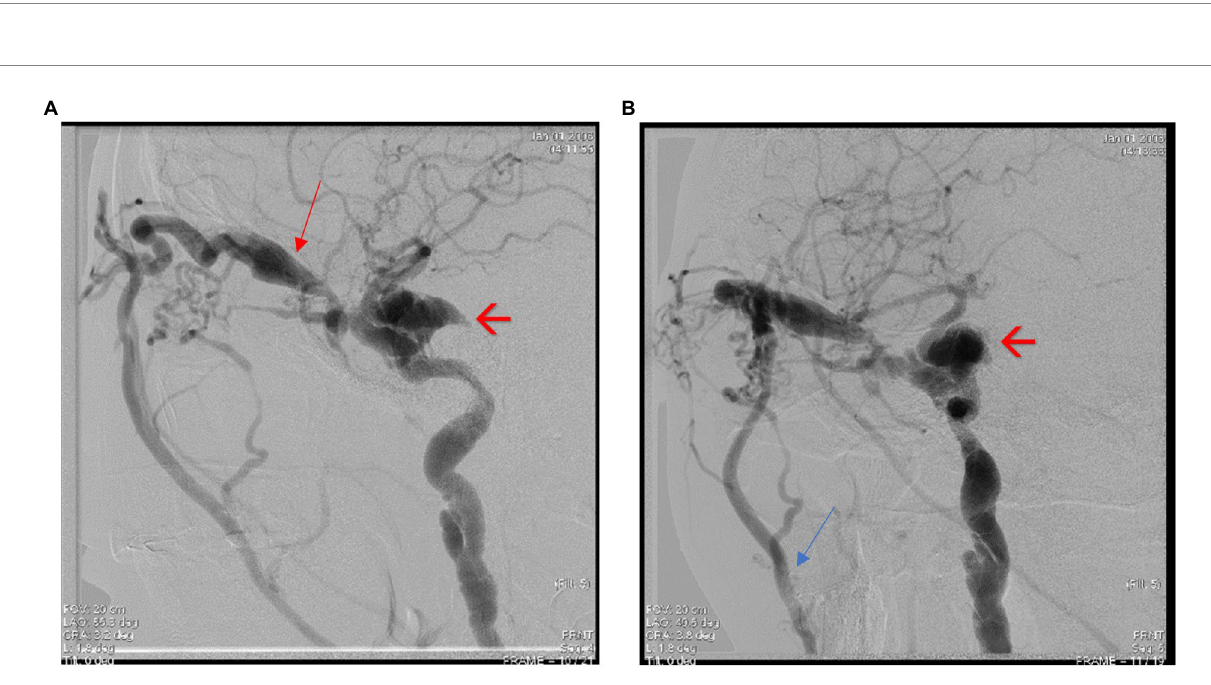
from a traumatic rupture of the wall of the cavernous internal carotid artery or because of the rupture of an aneurysm. Thus, arterial blood with high pressure gains rapid access to the venous system and leads to venous hypertension (6). Type B: dural fistulas with low flow, fed by the branches of the intra-cavernous internal carotid artery.